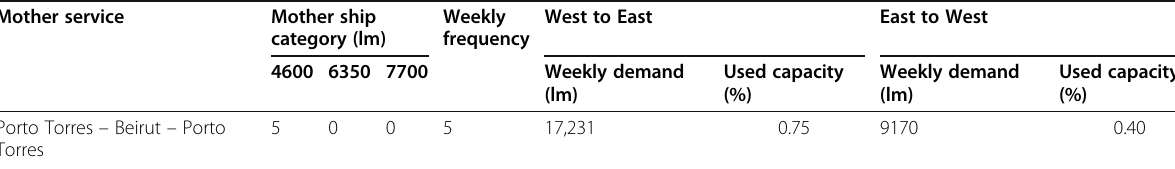
Table 21 Leg 2 – Mother services: frequencies and capacities Mother service